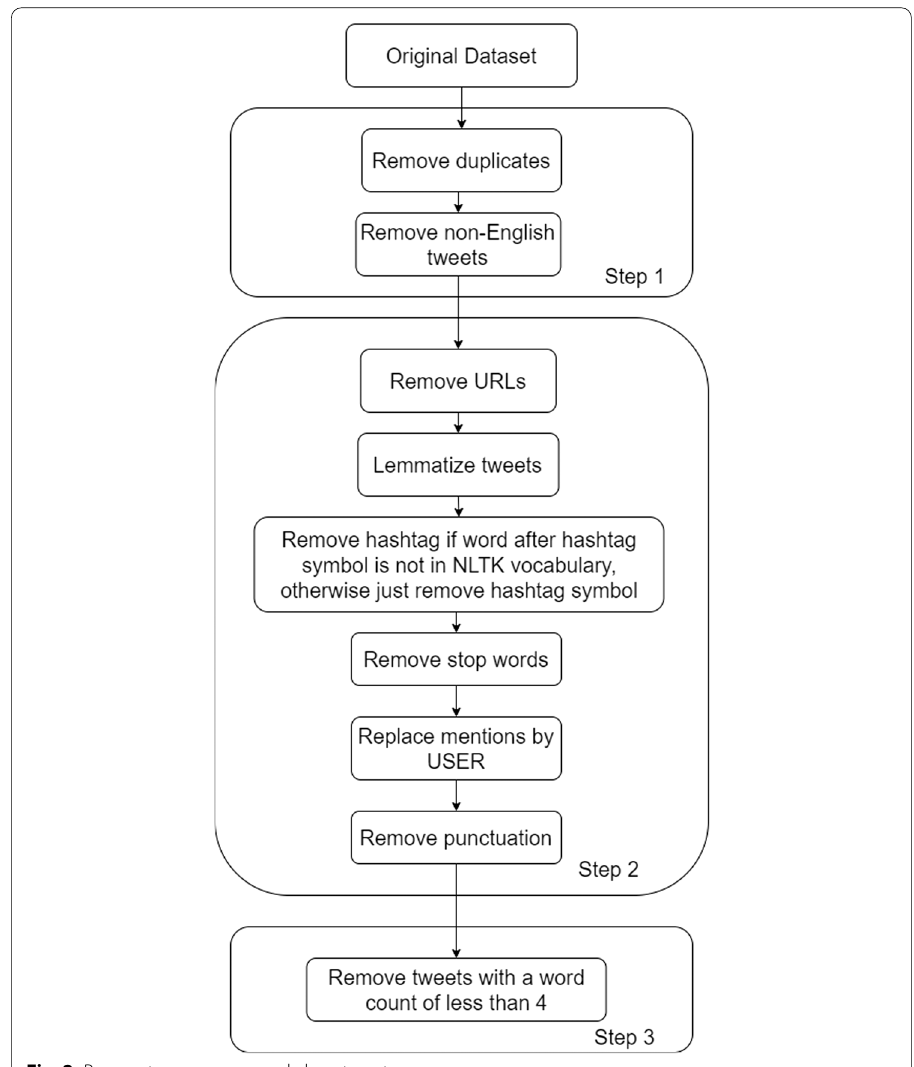
Fig. 2 Process to preprocess and clean